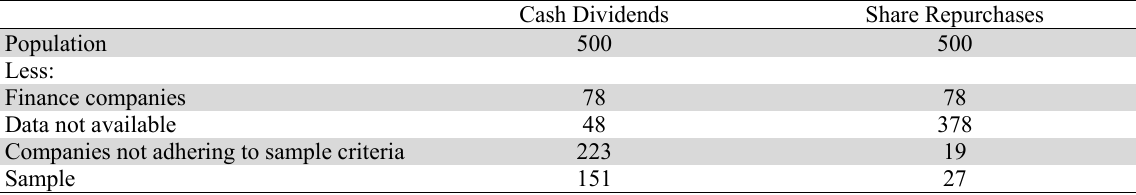
Sample Selection